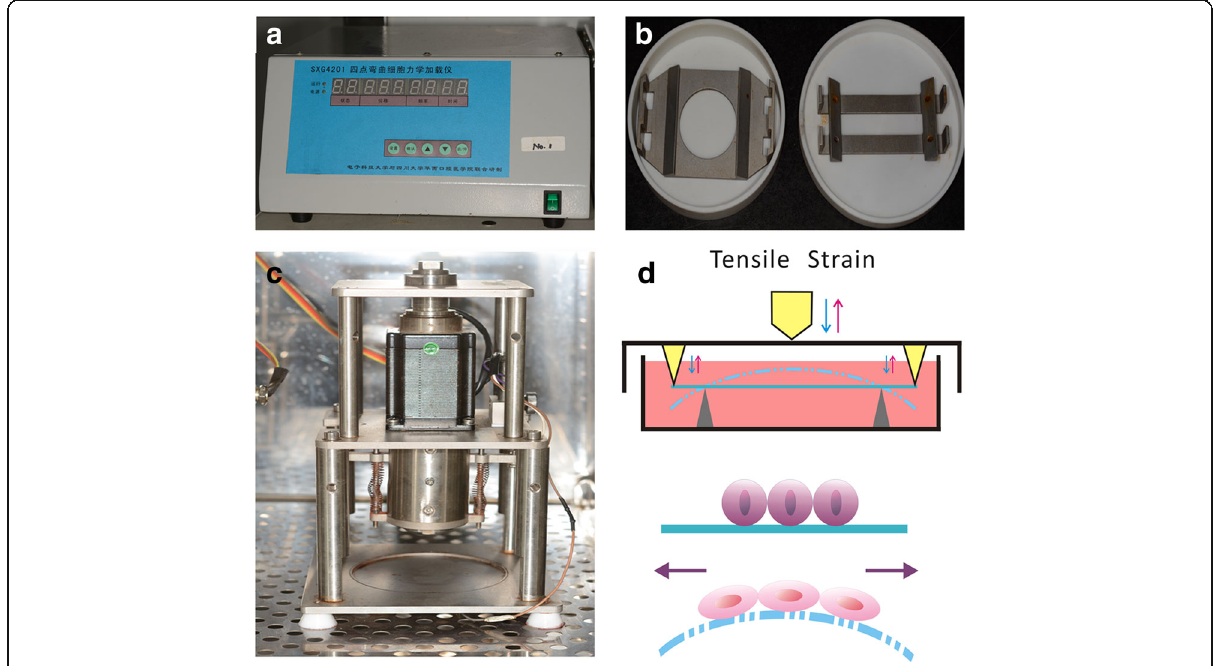
Fig. 2 Components and schematic diagram of the uniaxial four-point bending system. The uniaxial four-point bending system is made up of a a digital control unit, b bending boxes and c an actuator. d Schematic diagram illustrates how the four-point bending unit works. When the bending box is compressed by the actuator, the cell culture plate is bended by four points to generate tensile